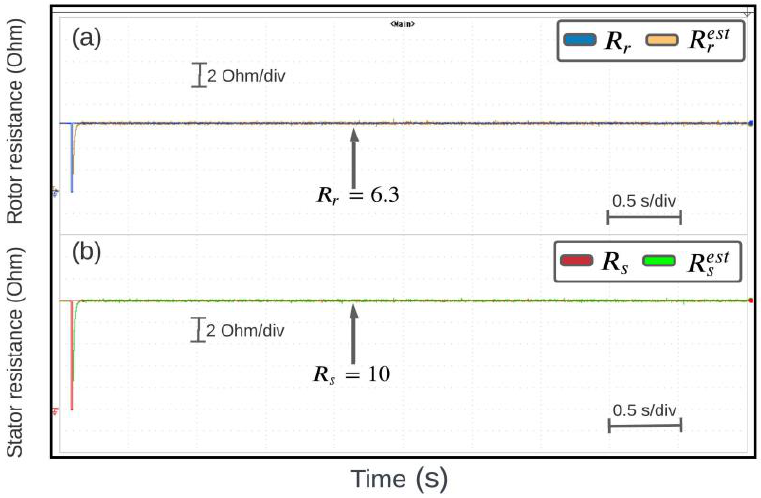
Figure 14. The motor resistances ( a ) rotor resistance; ( b ) stator resistance.